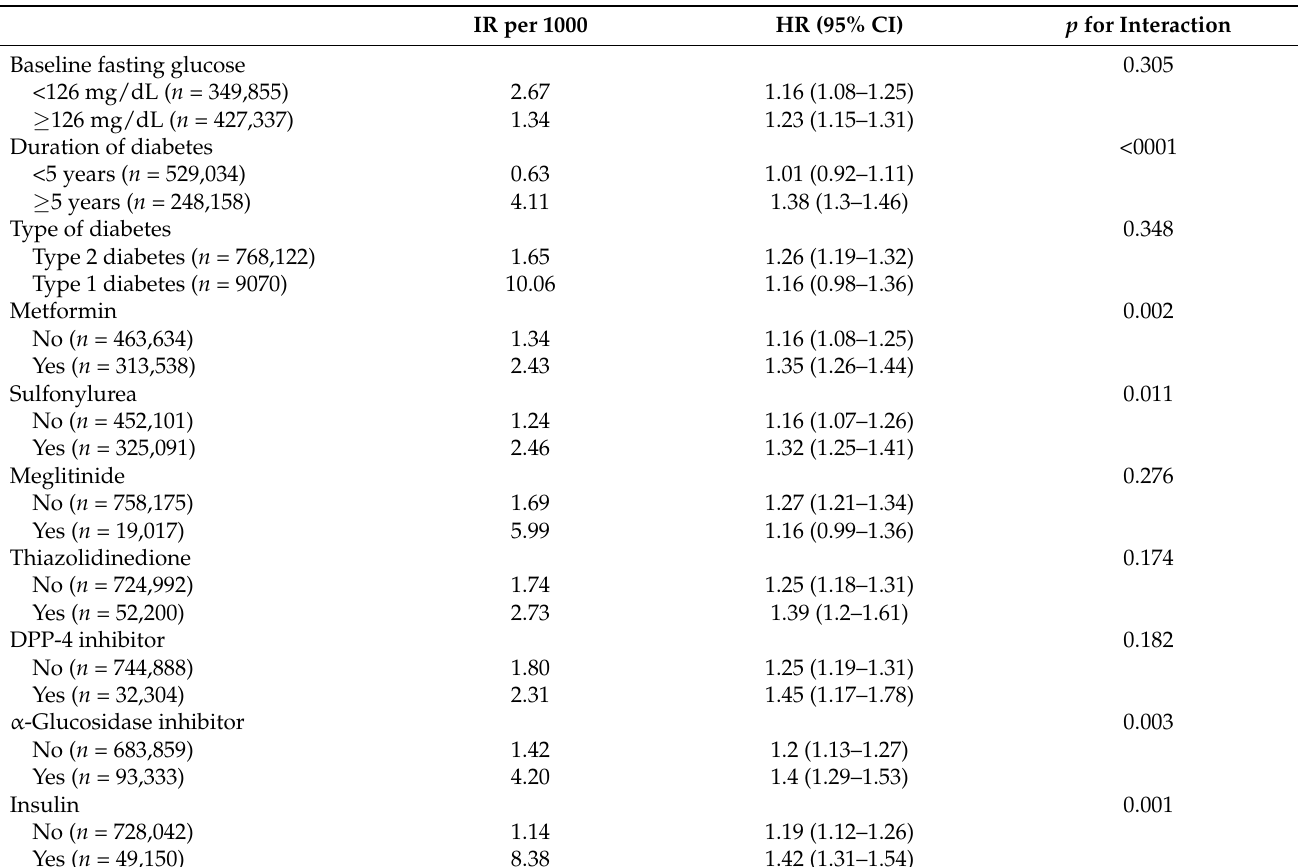
Table 4. Subgroup analysis according to the characteristics of diabetes in the fasting glucose variability quartile 4 versus quartiles